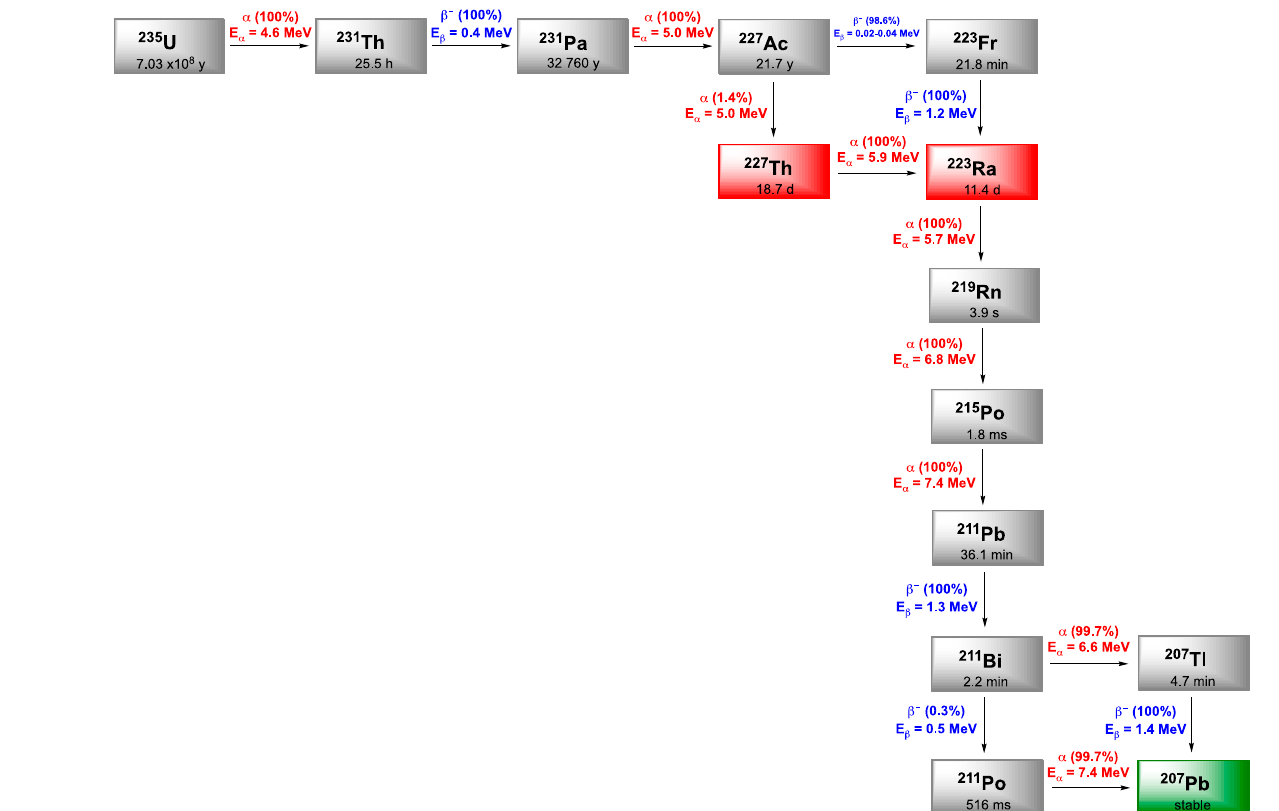
Figure 8. Decay schemes for the production of 223 Ra and 227